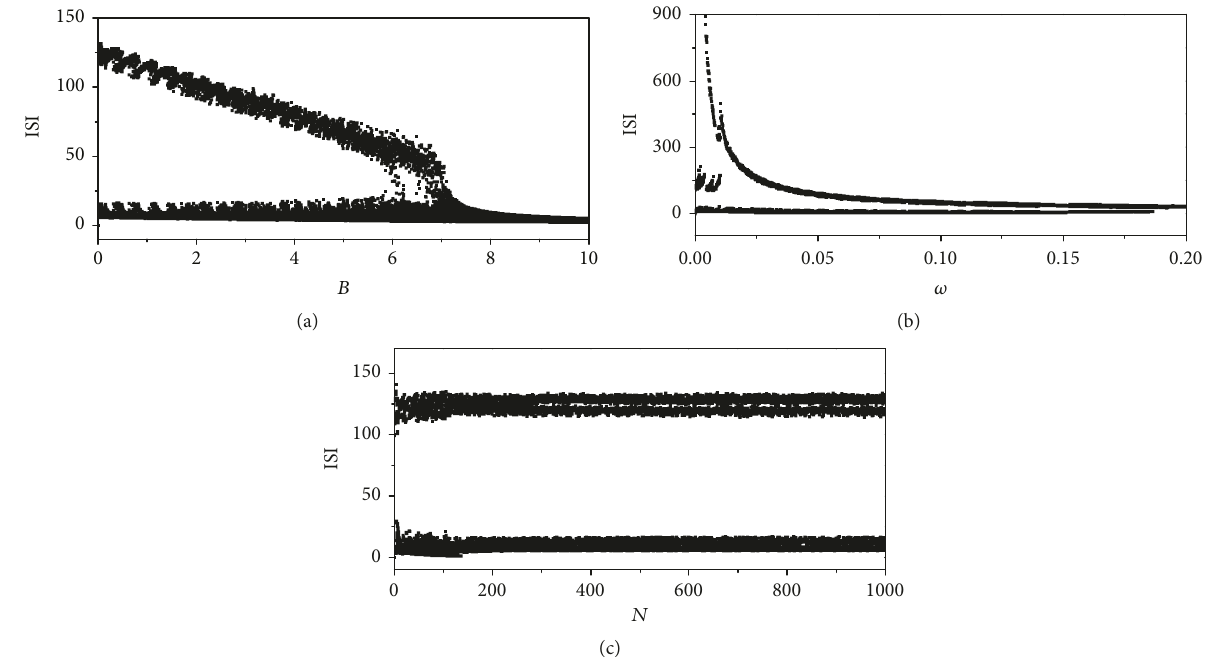
Figure 7: Bifurcation diagram with the increasing of different parameters. 𝐷 = 0.2 . (a) 𝐴 = 1.6 , 𝜔 = 0.04 , and 𝑁 = 200 . (b) 𝐴 = 1.6 , 𝐵 = 1.6 , and 𝑁 = 200 . (c) 𝐴 = 1.6 , 𝐵 = 1.6 , and 𝜔 = 0.04 .